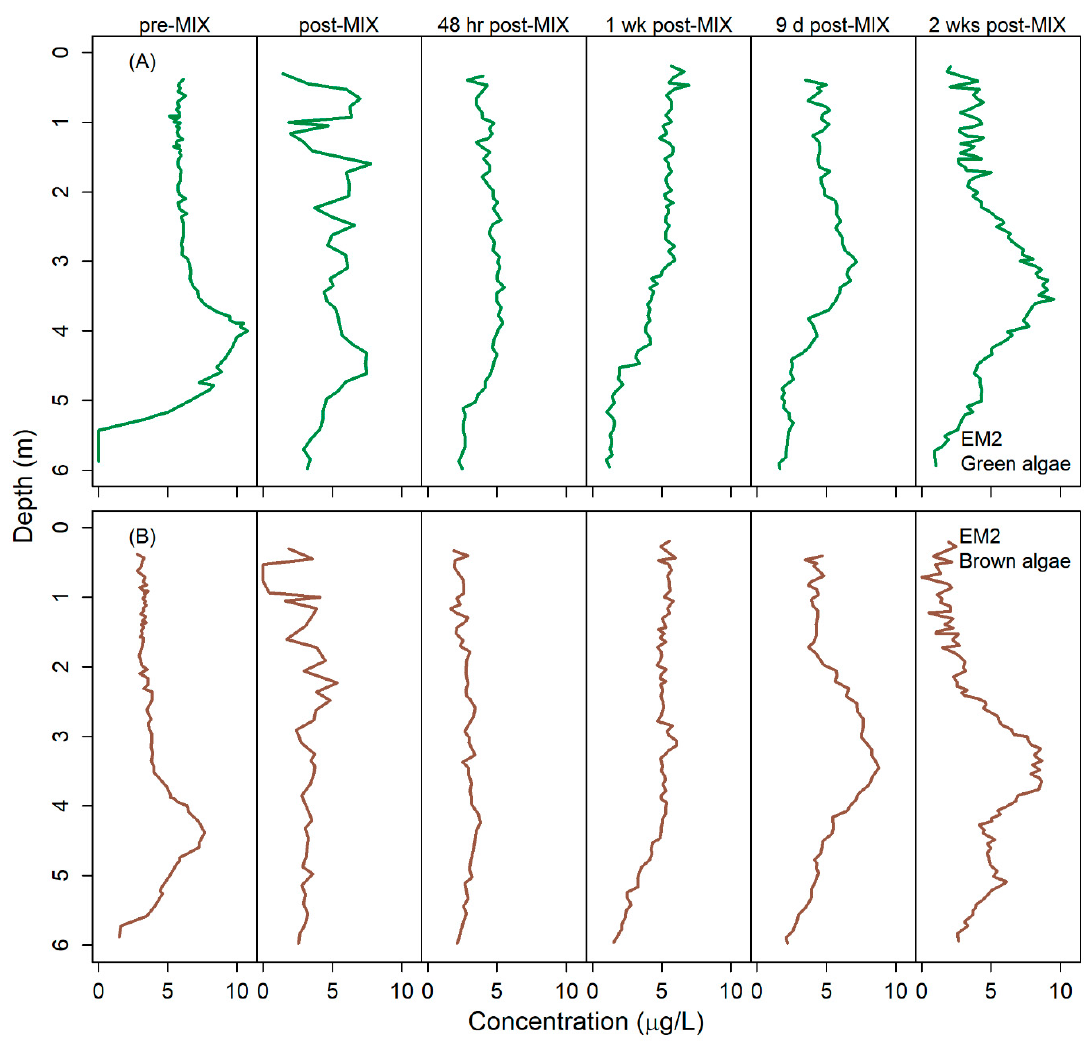
Figure 4. Epilimnetic concentrations of ( A ) green algae and ( B ) brown algae in Falling Creek Reservoir (FCR) before and after EM2. The response in depth profile patterns shown here exemplify patterns of recovery by phytoplankton spectral groups during both EM1 and EM2 (Figures S4 and S5). Pre-mix refers to 3–4 h prior to the experimental mixing, and post-mix refers to <1 h after mixing.